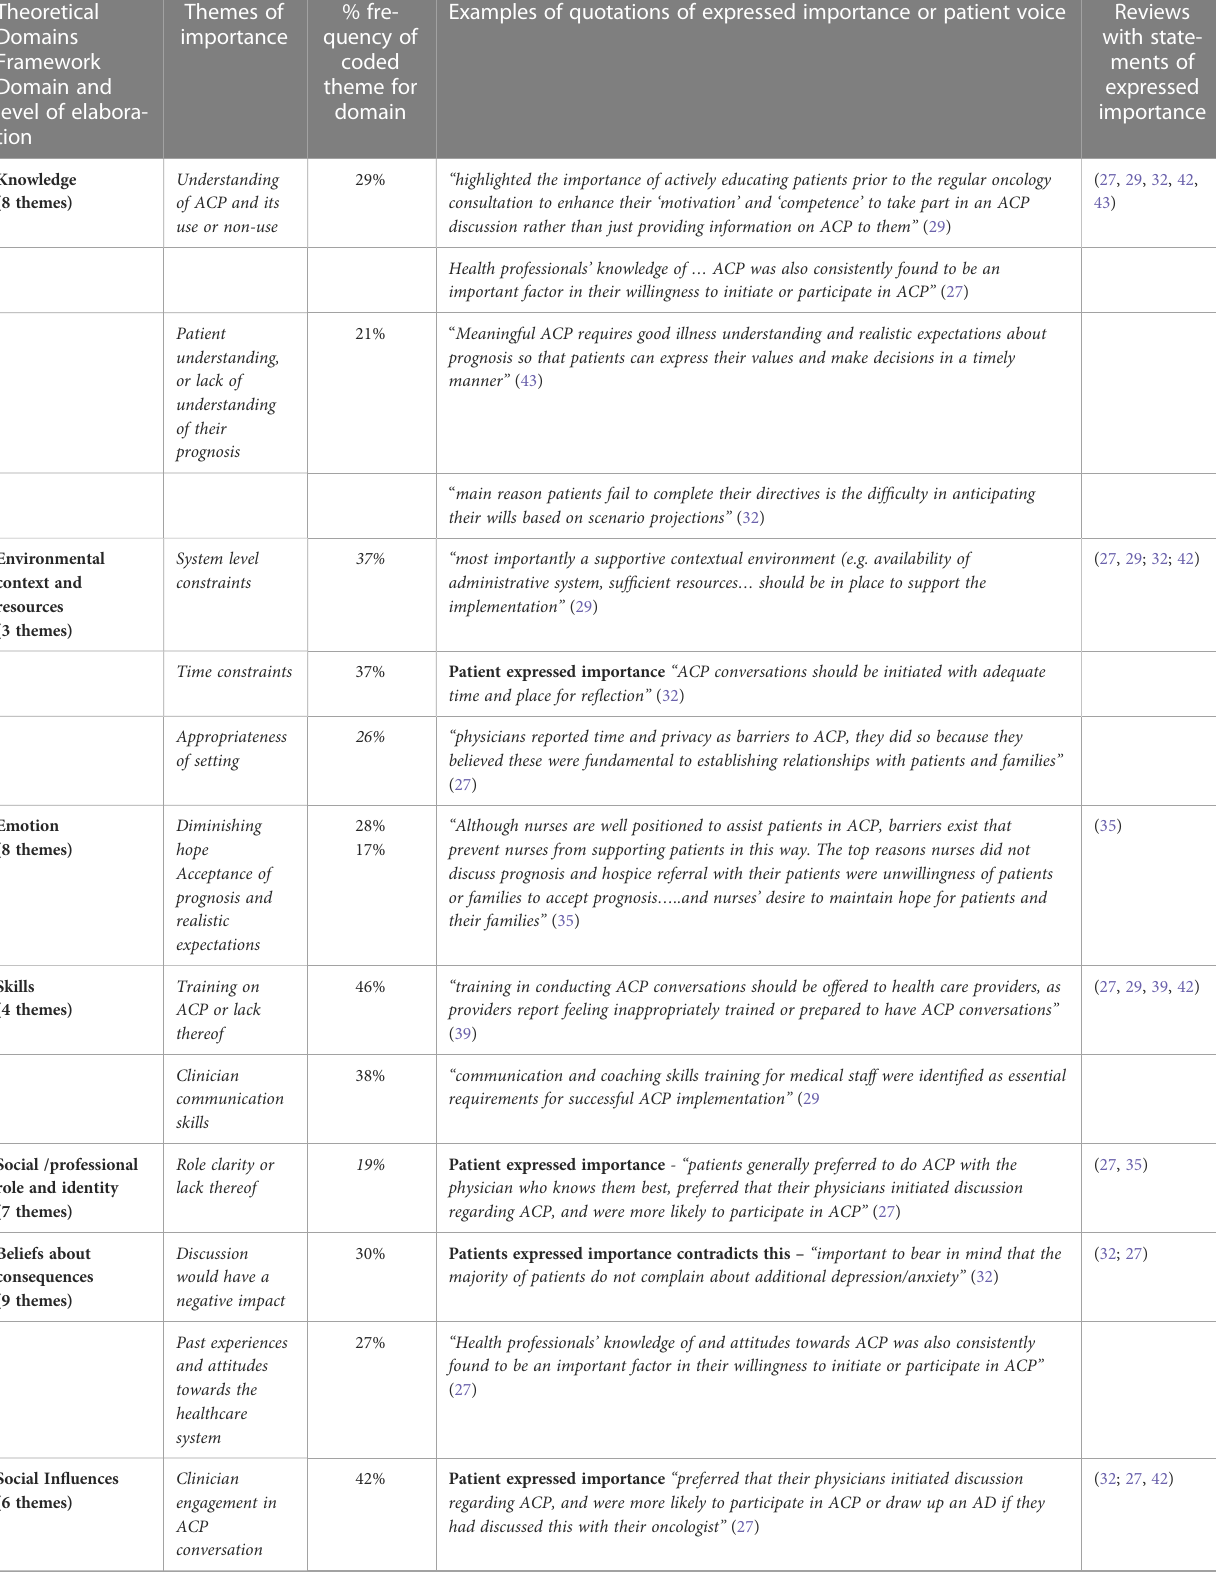
TABLE 4 Theoretical Domains Framework domains of importance in in fl uencing behaviours related to ACP; identi fi ed themes and quotations of expressed